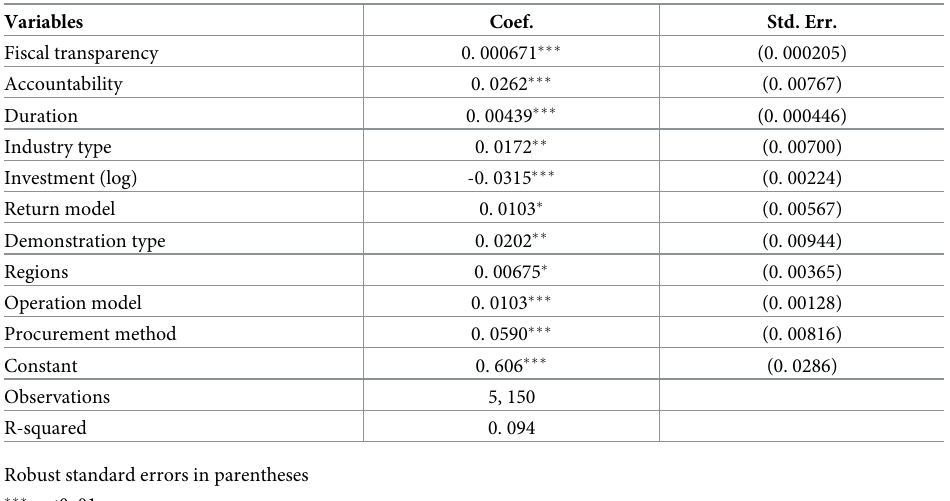
Table 6. Regression results of substitution proxy